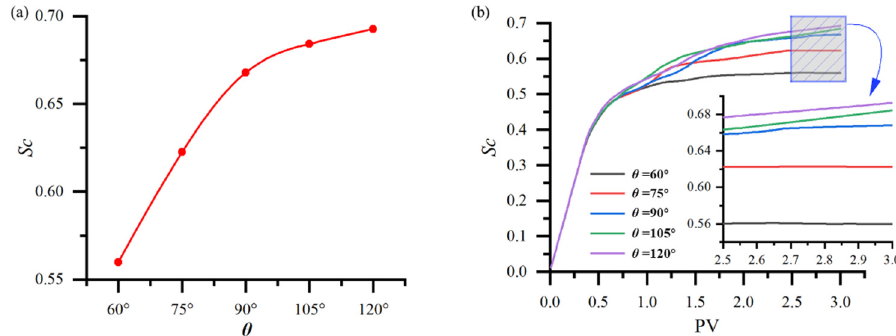
Figure 11. CO 2 saturation ( S C ) vs. contact angle ( a ) and PV number of CO 2 injection ( b ).